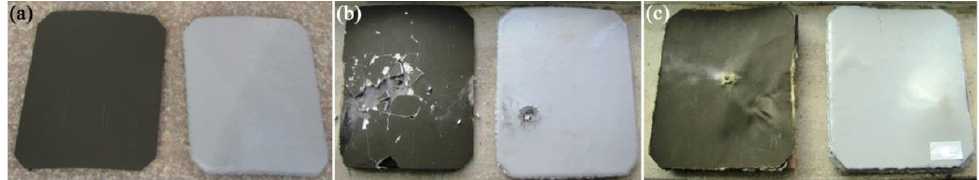
Figure 14. ( a ) Standard ballistic protection plate and MWCNT-OH-reinforced polyurea-coated ballistic protection plate before shooting; ( b ) exposed side after the shot; ( c ) reverse side after the shot. Reproduced with permission from ref. [69].